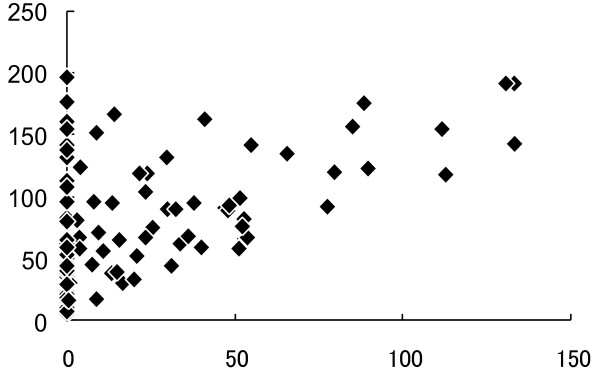
Period of donepezil use and life expectancy in AD. AD = Alzheimer’s disease. There was a significant Spearman correlation (Rs = 0.439, p < 0.0001) between the period of donepezil administration (months, horizontal line) and life expectancy (months, vertical line).